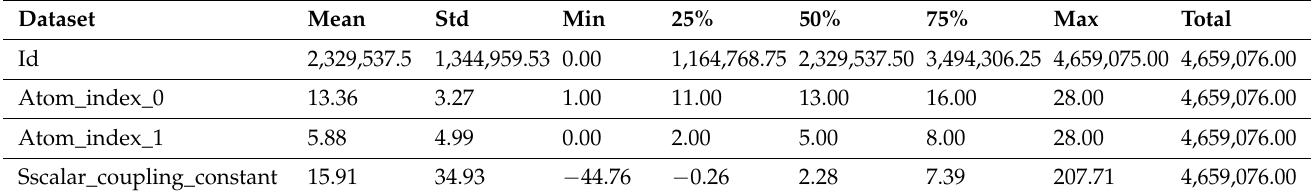
Figure 4. Top 10 molecule names for molecular properties. Table 3. Summary Statistics of the Molecular Properties